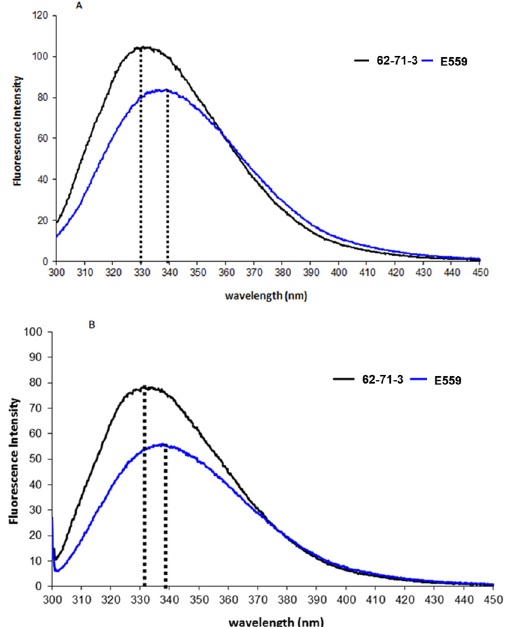
Fig 6. Fluorescence emission spectra of 62-71-3 (black) and E559 (blue). The mAbs were excited at 280 nm (A) and 295 nm (B). λ emm max for each mAb is marked with a dotted line.